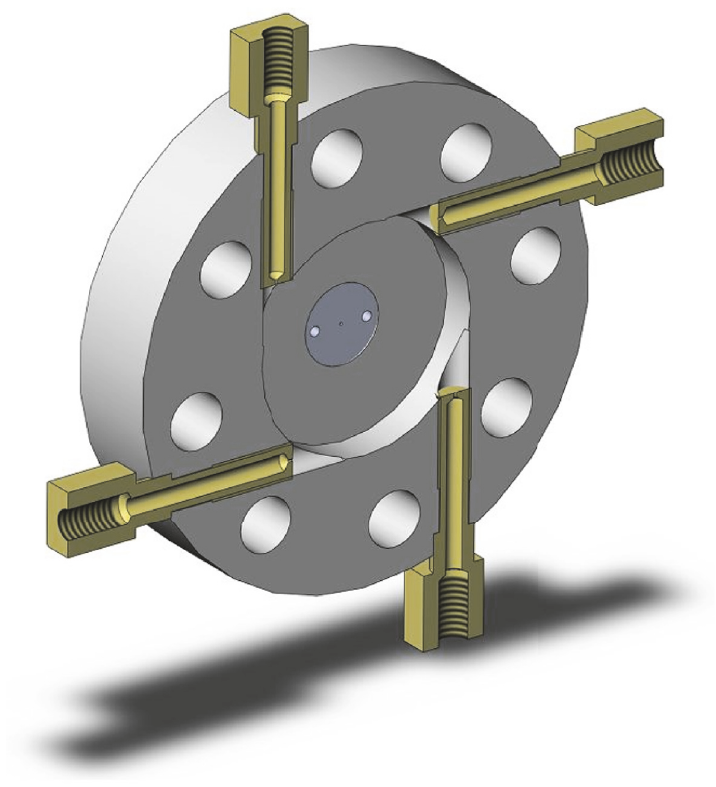
Figure 5: Section view of tangential injection